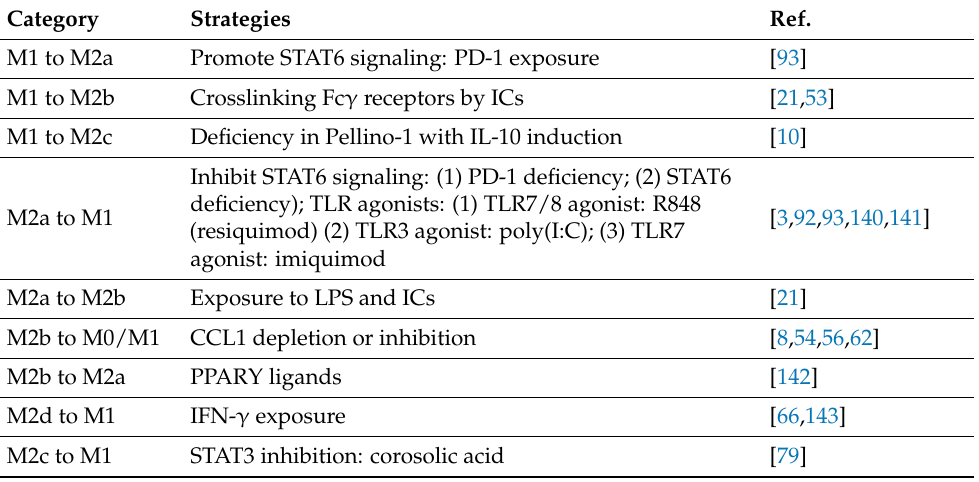
Table 3. Conversions between the macrophage subsets based on the published data.